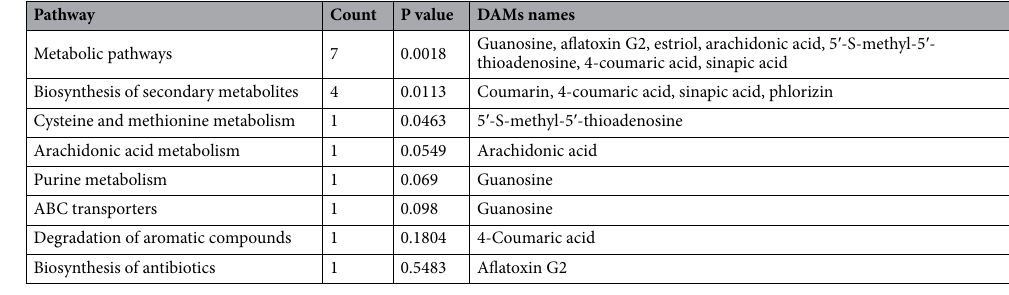
Table 3. Metabolic pathway enrichment with Pvalue < 0.05 in